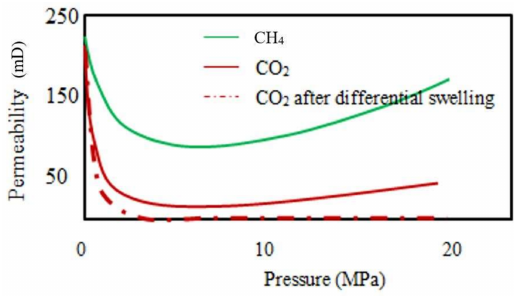
Figure 16. Differential swelling during CO 2 flow in coal